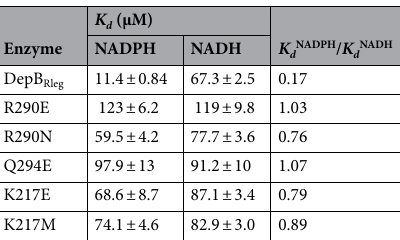
Table 3. Apparent coenzyme dissociation constants for purified recombinant DepB Rleg and coenzyme variants.